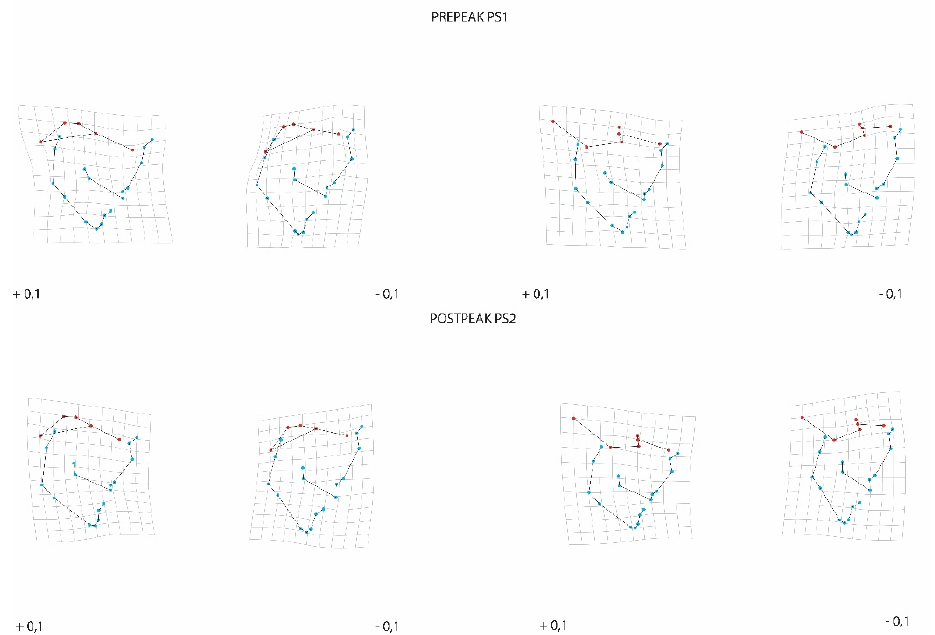
Figure 3. Deformation grids for an increase or a reduction of 0.1 in the single axis 1 for the different PLS analysis with a single superimposition. The structures of the cranial base are indicated in red, those of the facial skeleton in blue.